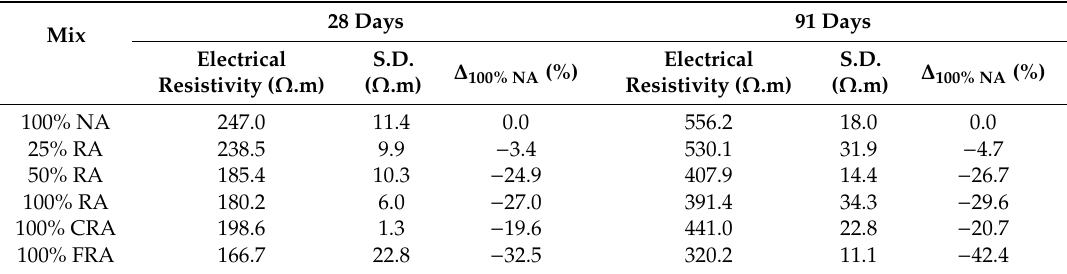
Table 9. Electrical resistivity results at 28 and 91